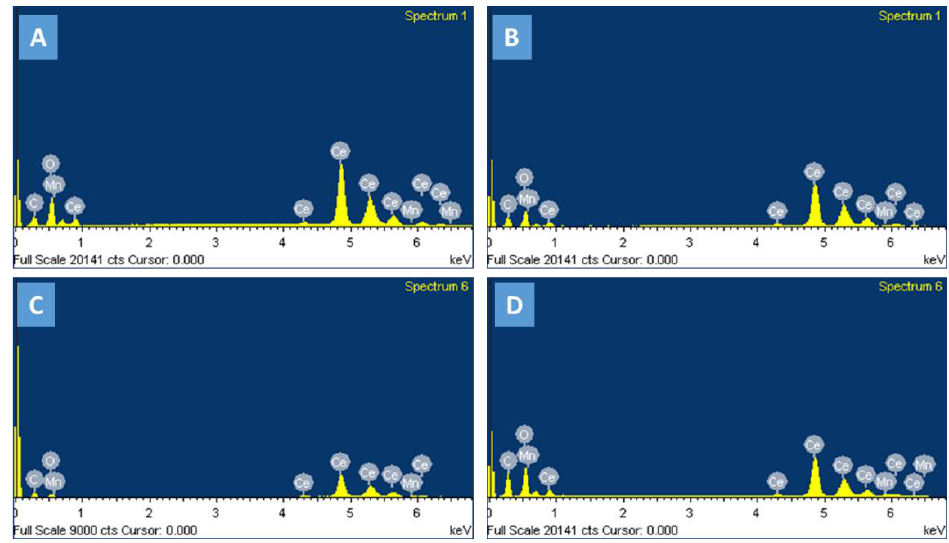
Figure 5. EDX analysis of Mn-doped porous ceria samples. ( A ) Mn-CeO 2 (1%), ( B ) Mn-CeO 2 (2.5%), ( C ) Mn-CeO 2 (5%), and ( D ) Mn-CeO 2 (10%).